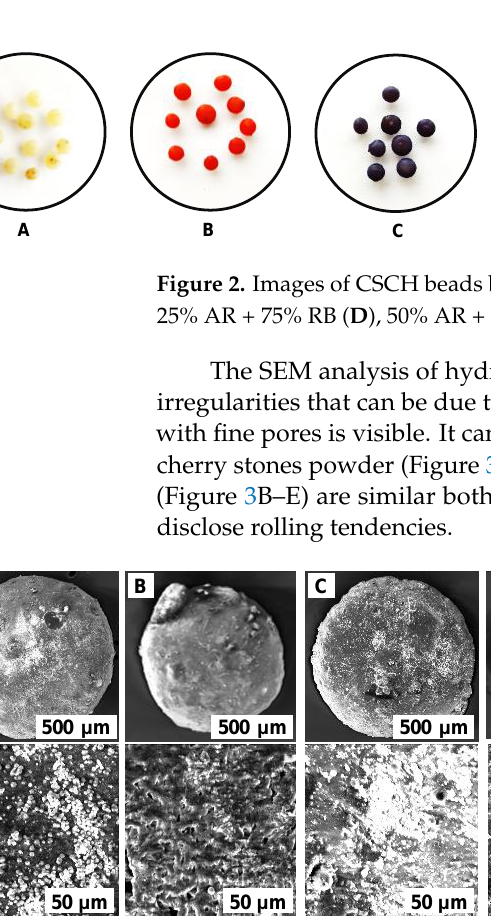
Figure 1. Hydrogel beads preparation procedure.